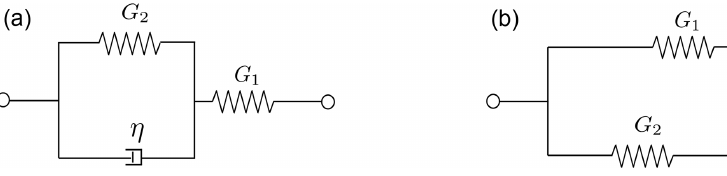
Figure 12. Standard linear solid models. Panels (a) and (b) respectively show the SLS KV and SLS Maxwell models.